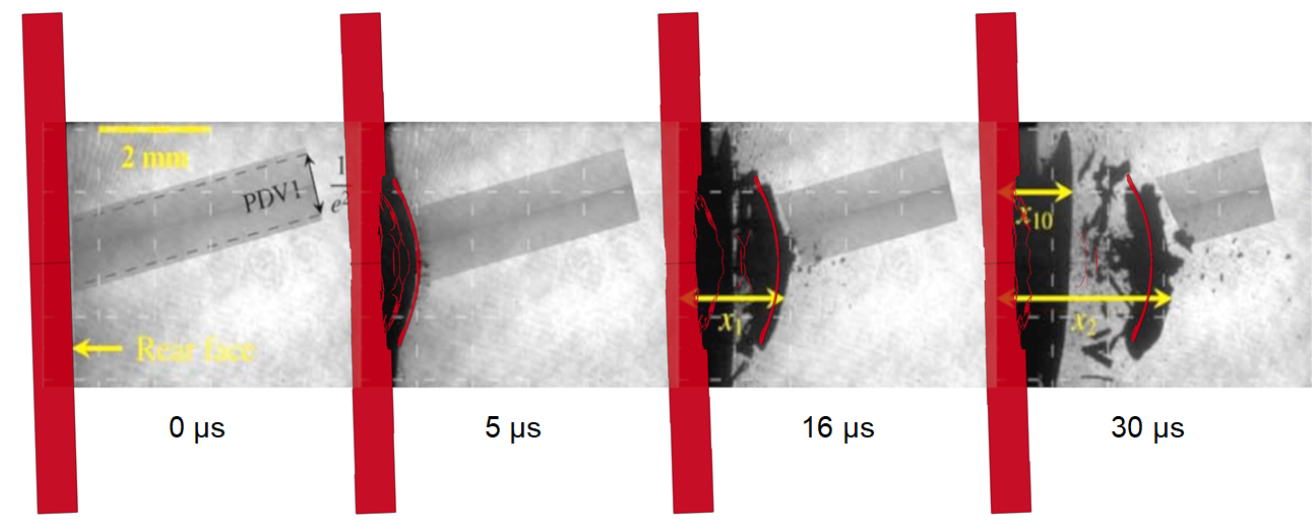
Figure 7. Comparison between numerical simulation and shadowgraphies of the shot S7 (reprinted from [28]).